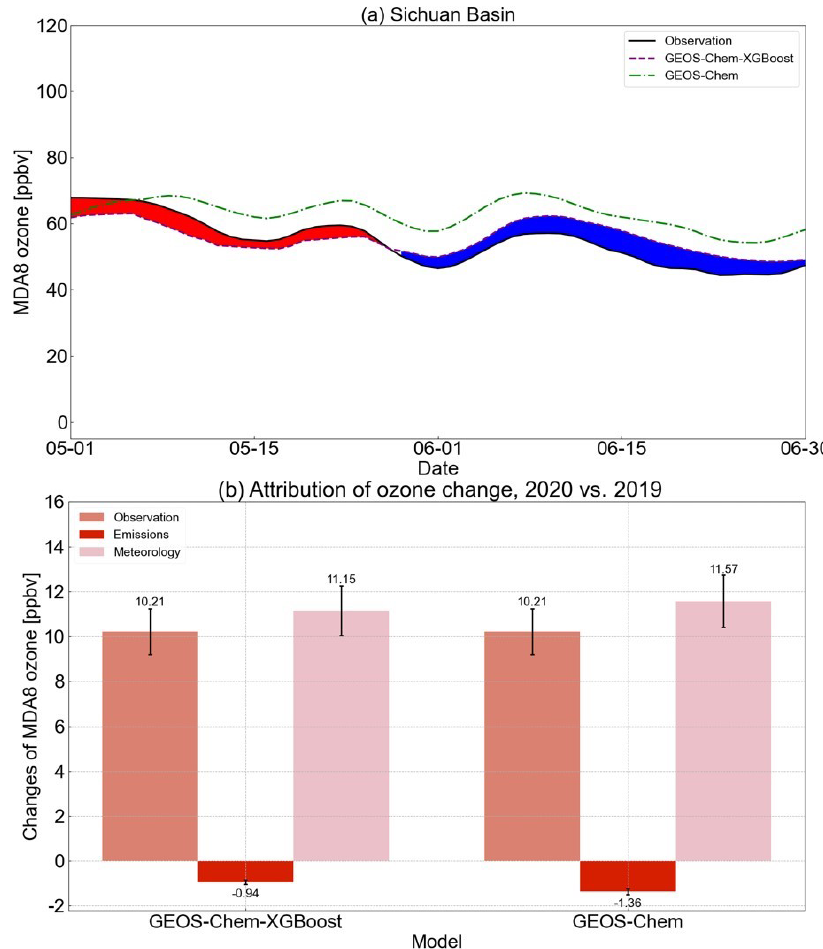
Figure 4. (a) Comparison of the GEOS-Chem-XGBoost O 3 predictions with the 2020 measurements. Red (blue) shading represents periods when GEOS-Chem-XGBoost predictions are higher (lower) than the actual measurements in 2020, indicating that changes in anthropogenic emissions led to an O 3 increase (decrease) in 2020. All values shown are 7d averages for presentation purposes. (b) Attribution of surface O 3 enhancements over the SCB in May–June 2020 relative to 2019. Filled coloured bars denote O 3 change as seen from measurements as well as O 3 change due to changes in anthropogenic emissions and meteorological conditions estimated by the GEOS-Chem-XGBoost model and the GEOS-Chem model. Black vertical bars represent 1 σ SD across